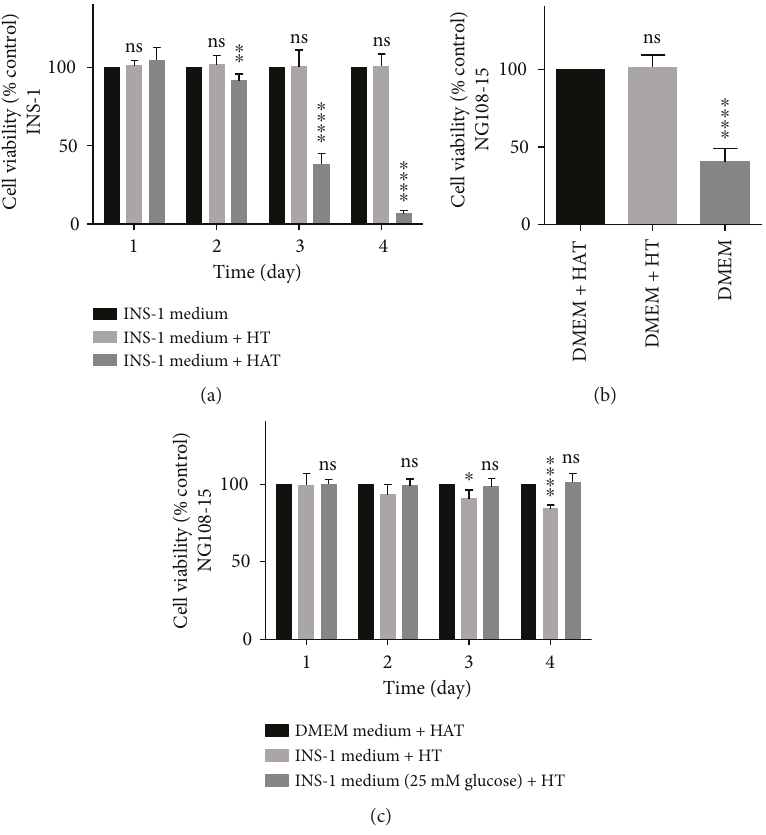
Figure 2: INS-1 medium supplemented with HT is the ideal medium for short-term coculture. (a, b, and c) Cellular viability was determined by CCK-8 kits and the data were expressed as percentages of untreated control cells. Results are means ± SD of four independent experiments. (a) INS-1 cells were cultured in INS-1 medium (control) with or without HT or HAT. ∗∗ p < 0 01 and ∗∗∗∗ p < 0 0001 and ns versus INS-1 medium group, n = 4 . (b) NG108-15 cells were cultured in DMEM medium with or without HT or HAT. Cellular viability of NG108-15 cells was determined after 24-hour culture. ∗∗∗∗ p < 0 0001 and ns versus DMEM +HAT group, n = 4 . (c) NG108-15 cells were cultured in DMEM medium with HAT, INS-1 medium with HT, and INS-1 medium (25 mM Glucose) with HT, respectively. ∗ p < 0 05 and ∗∗∗∗ p < 0 0001 and ns versus DMEM medium+ HAT group, n = 4